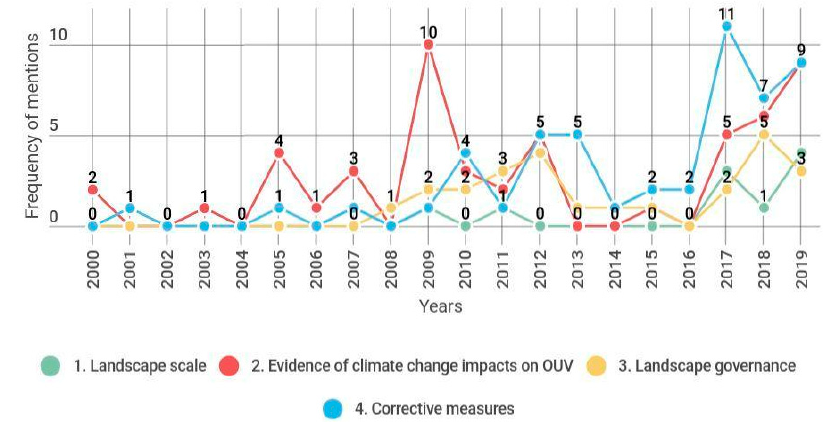
Figure 5. Mentions identified as landscape-based conservation principles (coding dimension